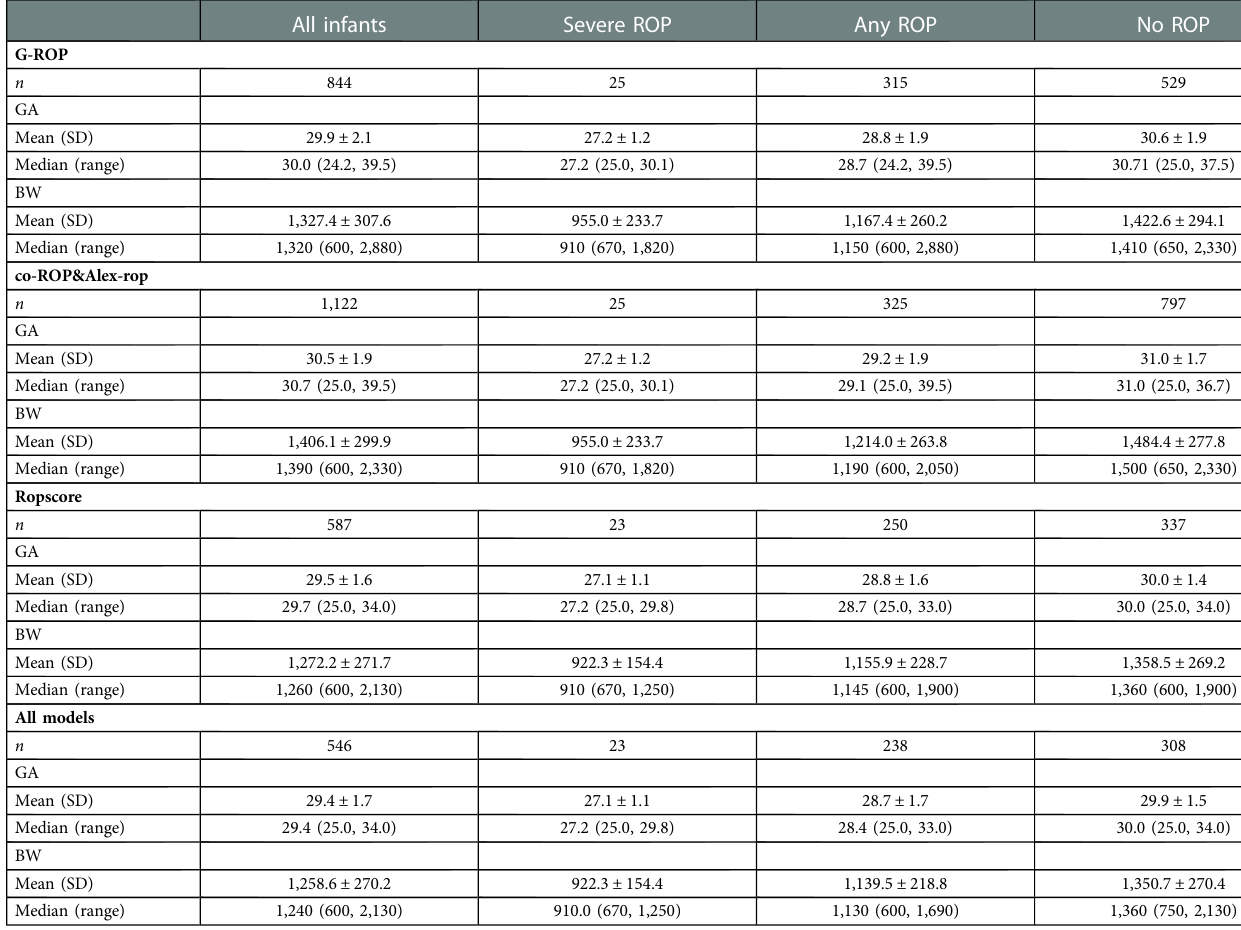
TABLE 1 Characteristics of infants included in G-ROP, CO-ROP, Alex-ROP and ROPscore. All infants Severe